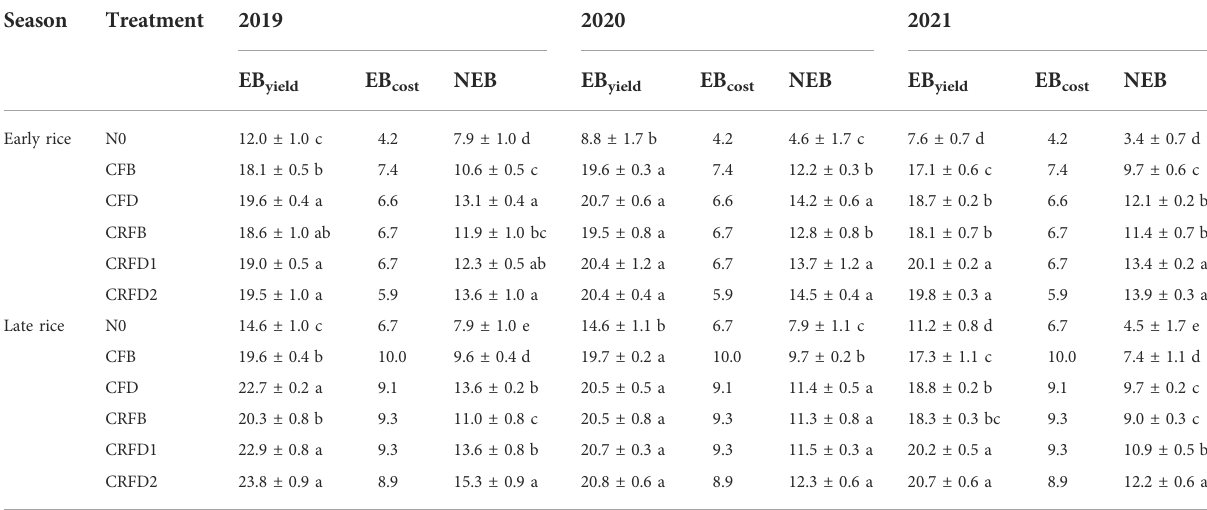
TABLE 3 The economic bene fi t and net economic bene fi t for early rice and late rice under different treatments in 2019, 2020 and 2021 (×10 3 yuan ha − 1 ).